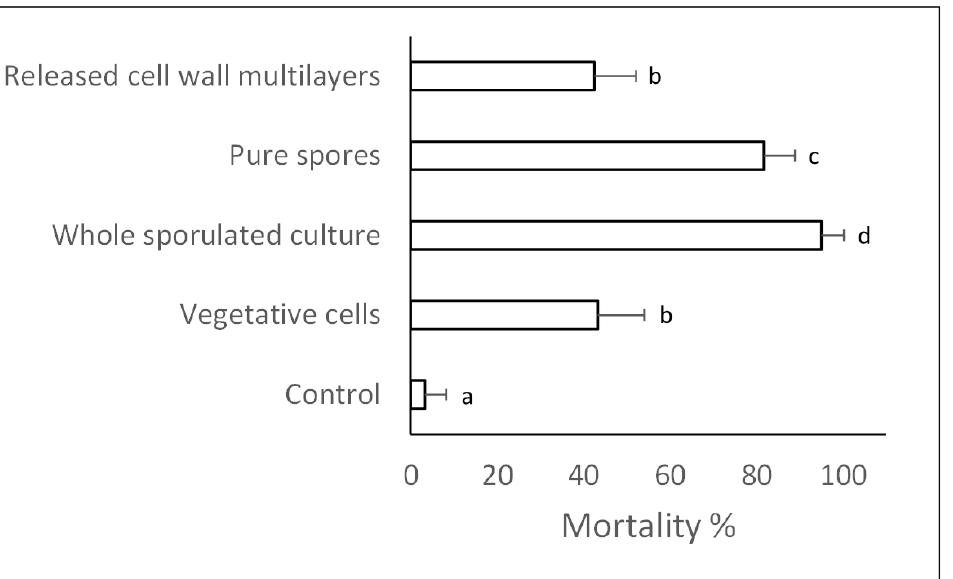
rate and the protein concentration (adjusted R 2 = 0.8149, F = 313.5, p < 0.0001) (Figure